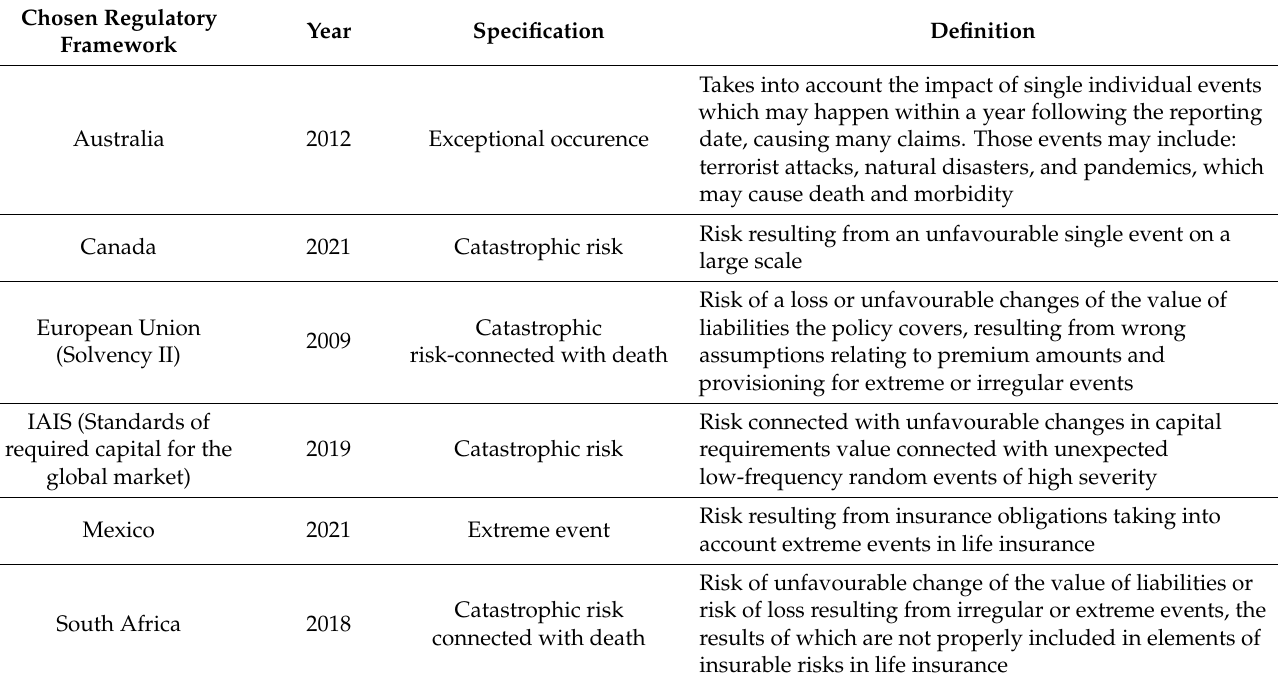
Table 1. Comparison of risk categories with the COVID-19